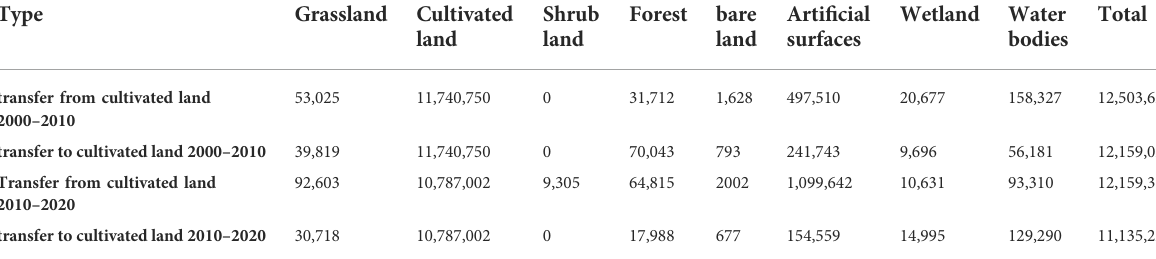
TABLE 2 Aggregate converted area of cultivated land resources during 2000 – 2020 (ha).